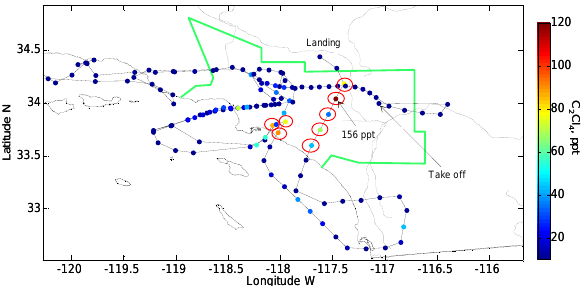
Fig. 5. Geographic distribution of samples collected during Flight Figure 5. Geographic distribution of samples collected during Flight 12, color-coded by C 2 Cl 4 12, color-coded by C 2 Cl 4 mixing ratios (the line connecting the mixing ratios (the line connecting the samples illustrates the flight path). The samples circled samples illustrates the flight path). The samples circled in red cor- in red correspond to canisters showing greatly enhanced halocarbon levels. respond to canisters showing greatly enhanced halocarbon levels.